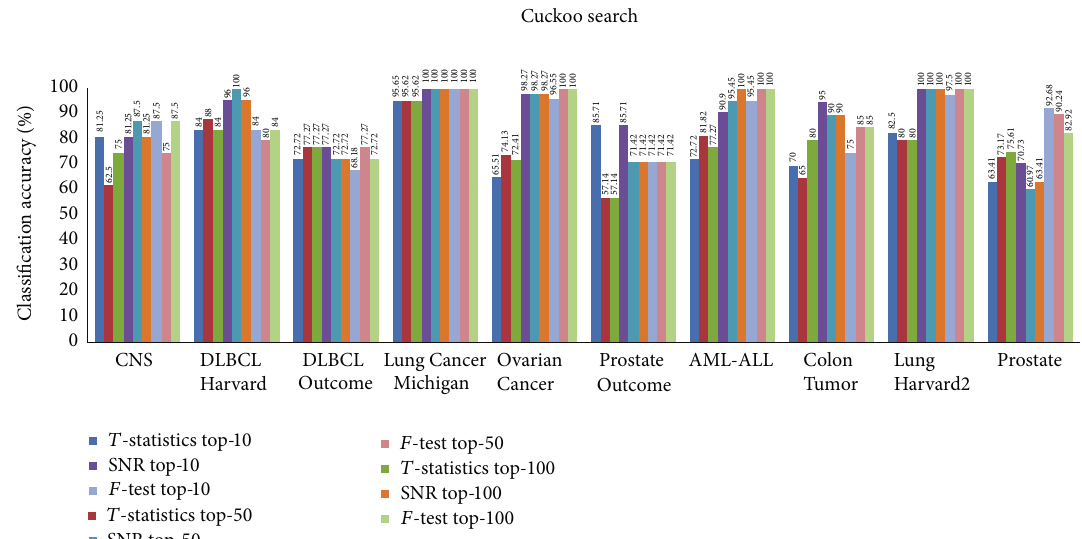
Figure 4: Classification accuracy using cuckoo search.